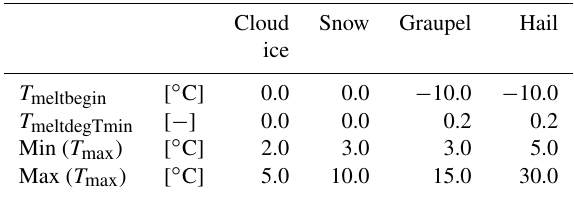
Table A1. Overview of EMVORADO melting scheme setup used in this study. Cloud